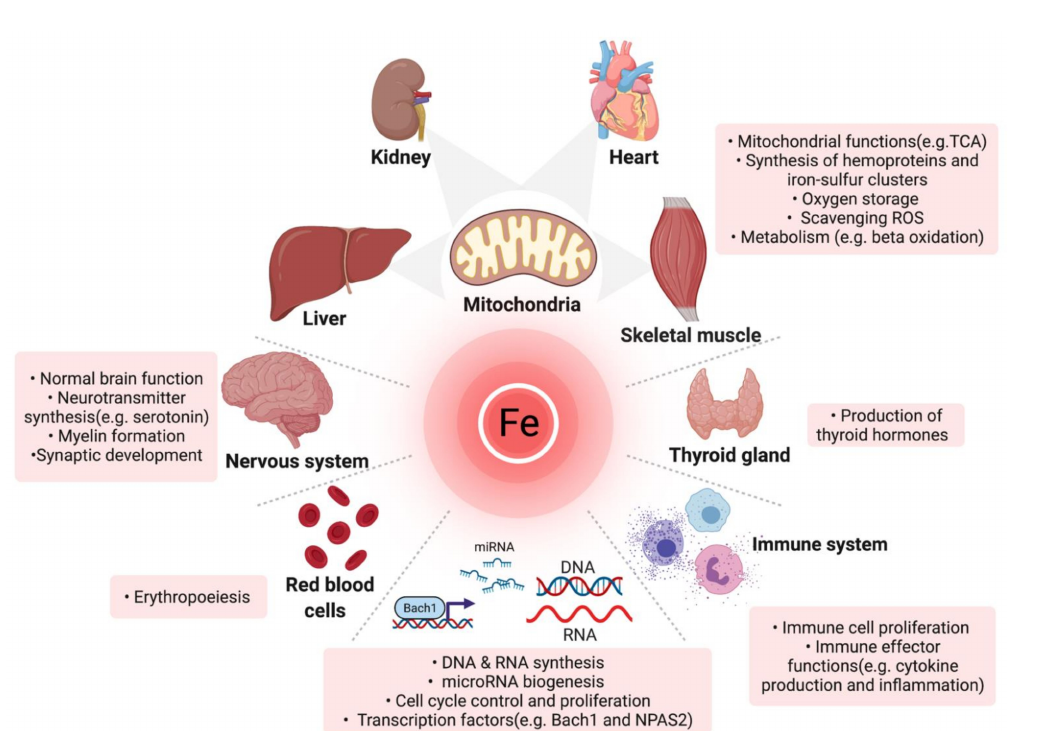
Figure 1. Overview of the multifaceted roles of iron in diverse organs and molecular processes. TCA: tricarboxylic acid cycle; miRNA: microRNA, ROS: reactive oxygen species (Created with BioRender.com, accessed on 24 November